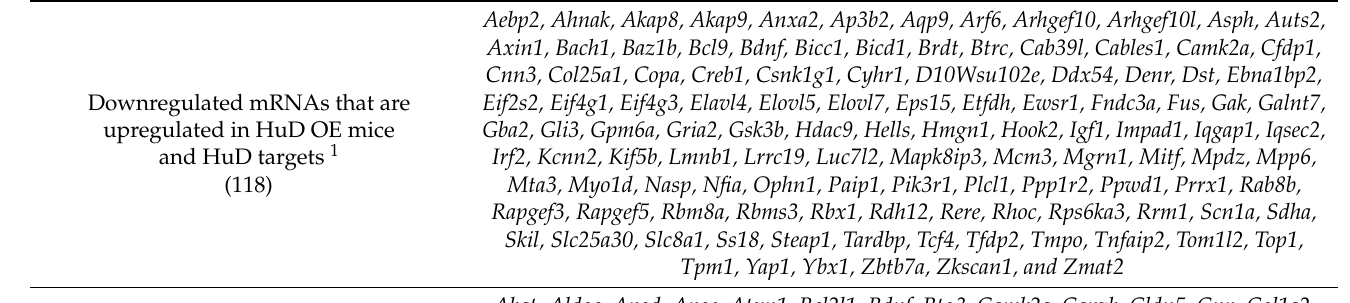
Downregulated mRNAs that